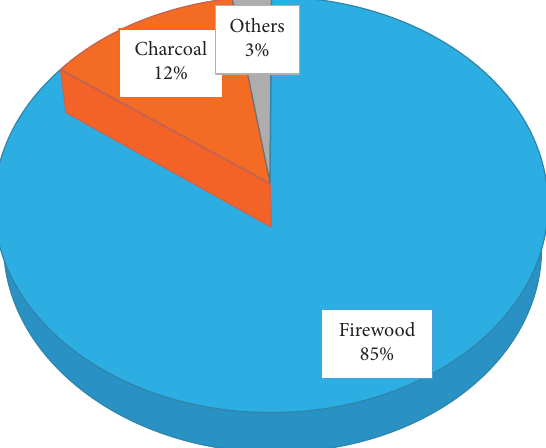
Figure 2: Percentage share of various biomass energy resources in